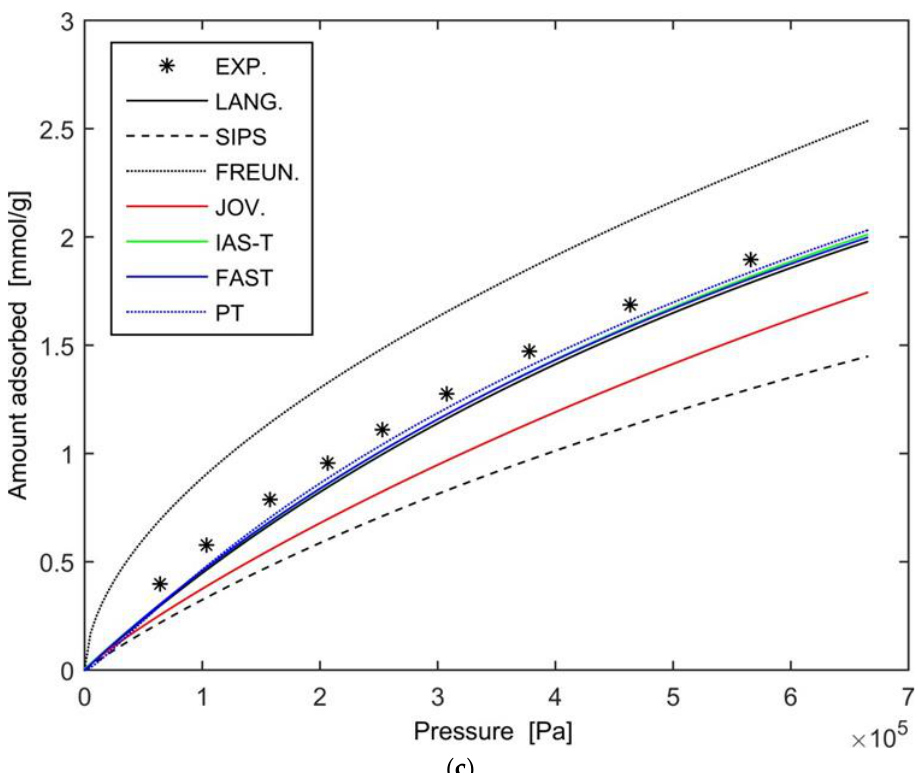
Figure 4. ( a ). Adsorption results of hydrogen gas from mixture corresponding to case N° 2; ( b ). Adsorption results of nitrogen gas from mixture corresponding to case N° 2; ( c ) Adsorption results of methane gas from mixture corresponding to case N° 2.